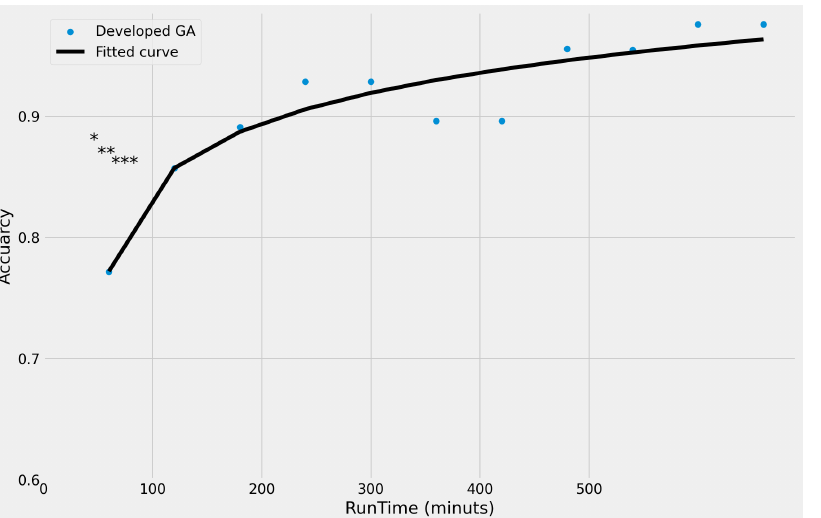
Figure 10. Comparing the computational time and accuracy of the developed GA with other algo- rithms: (*) GA [23,24], (**) PSO [24–26], and (***) DE [24,27]. The line fit is for visual purposes